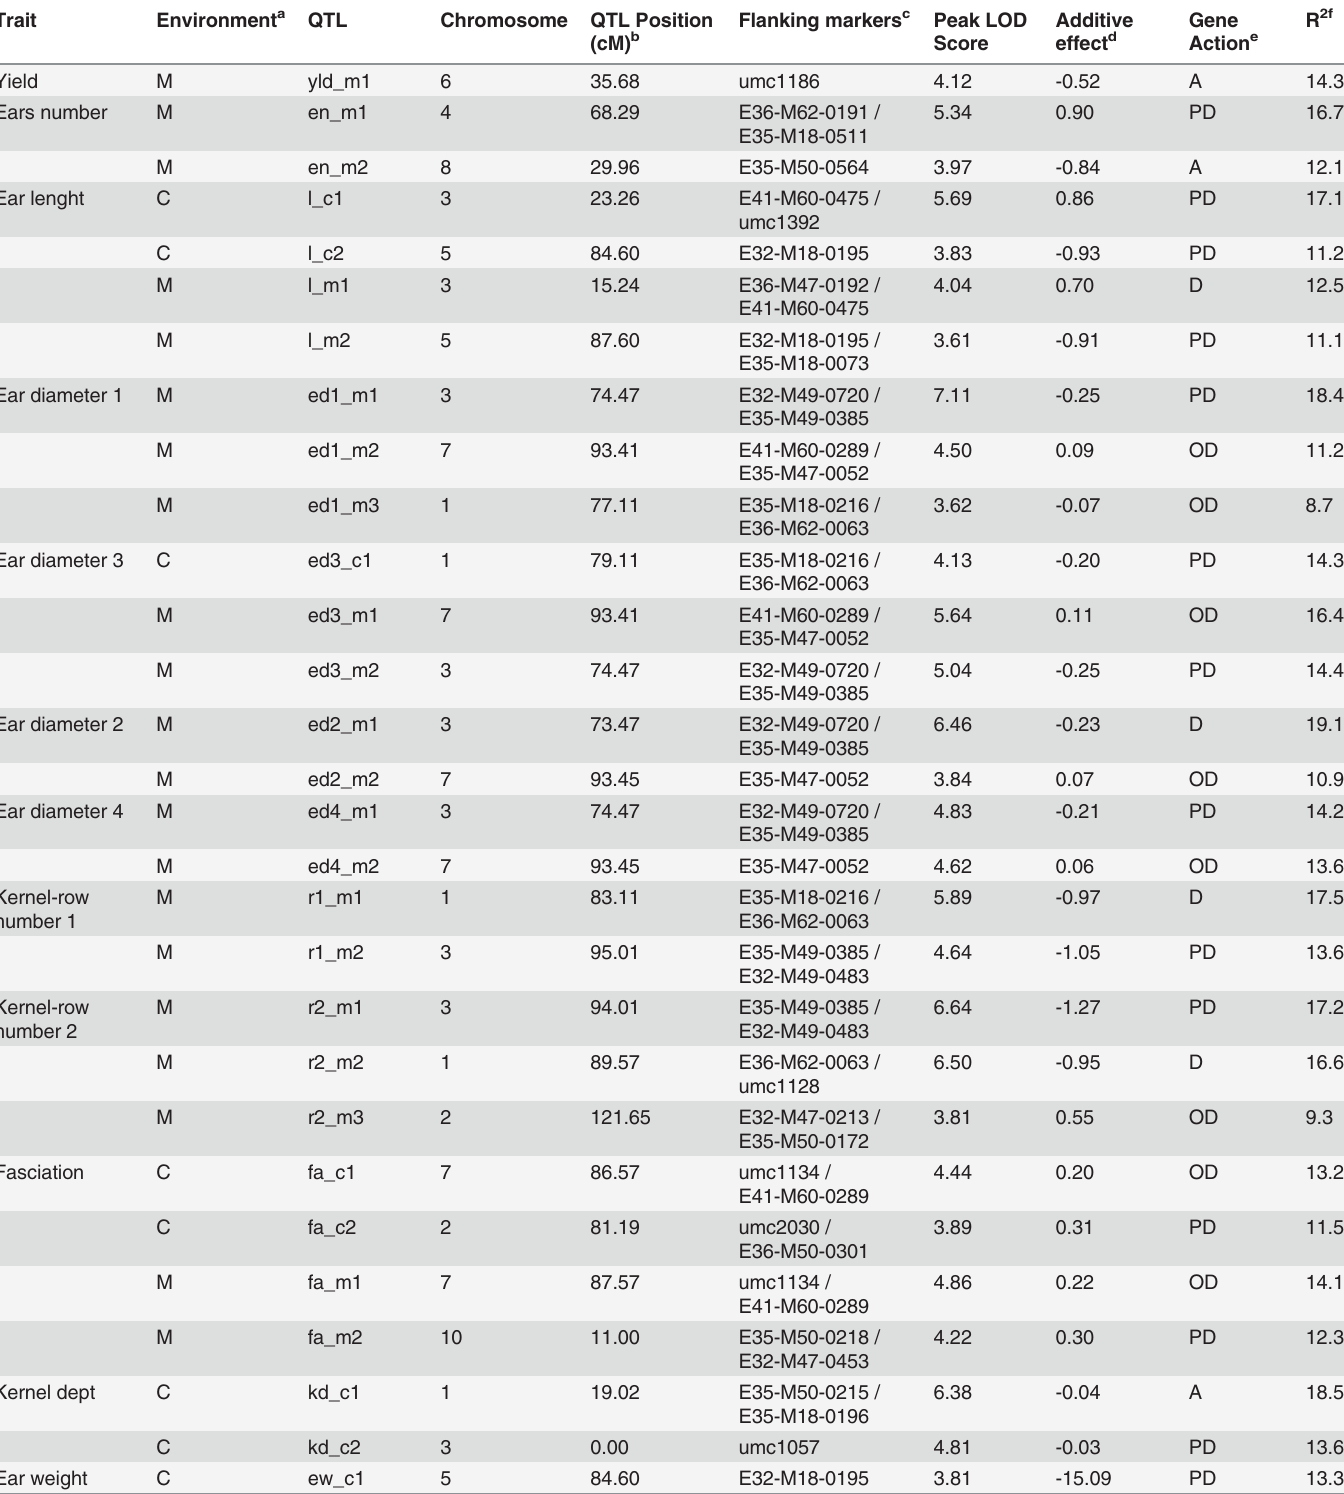
Table 4. Quantitative Trait Loci for fasciation and related ear traits, estimated from 149 F 2:3 maize families (PB260 x PB266).